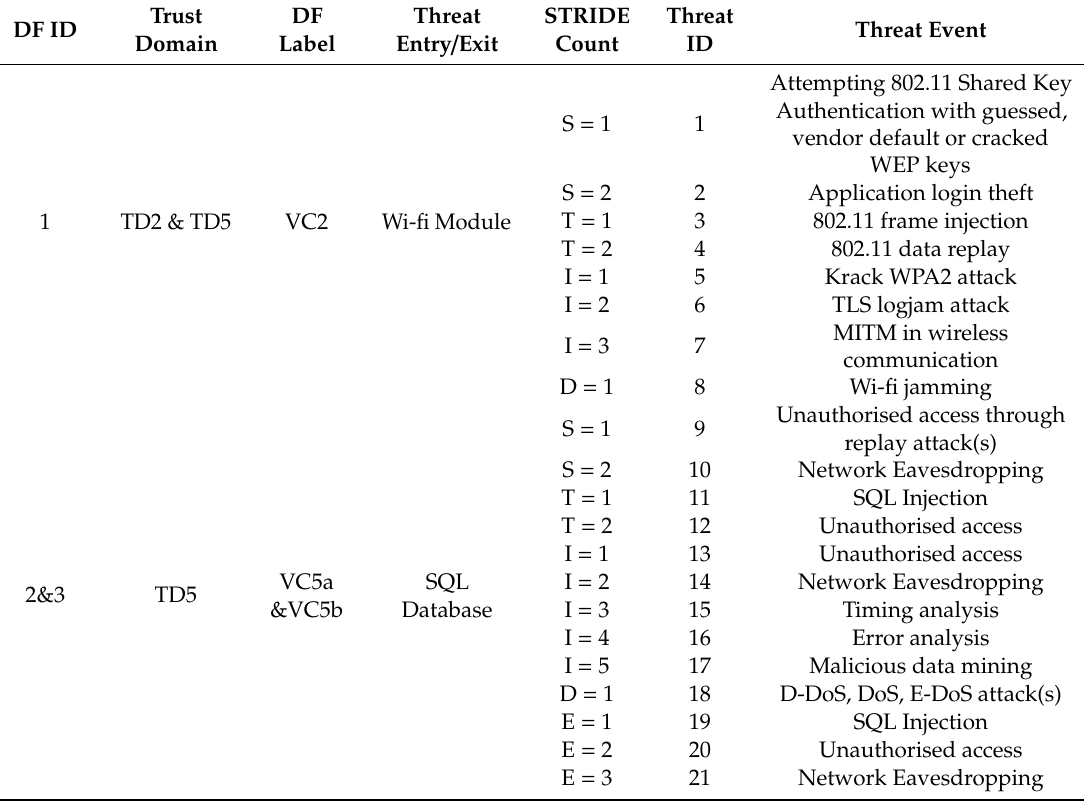
Table 2. Identification of STRIDE threats for Database access in